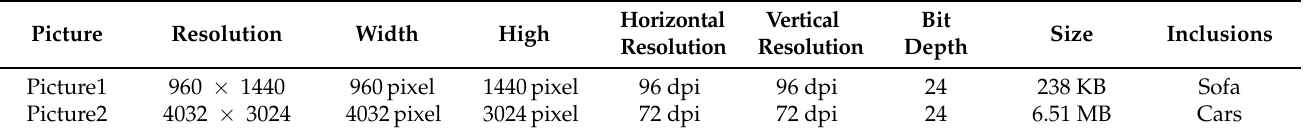
Table 2. The image parameters.